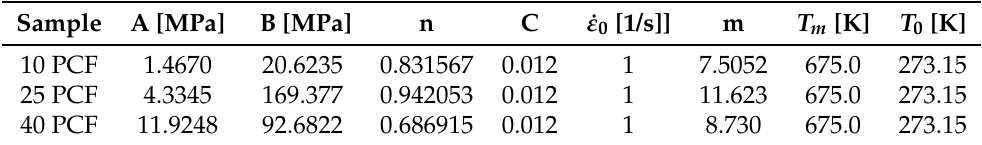
Table 2. Johnson–Cook model parameters for rigid polyurethane foams with density of 10, 25 and 40